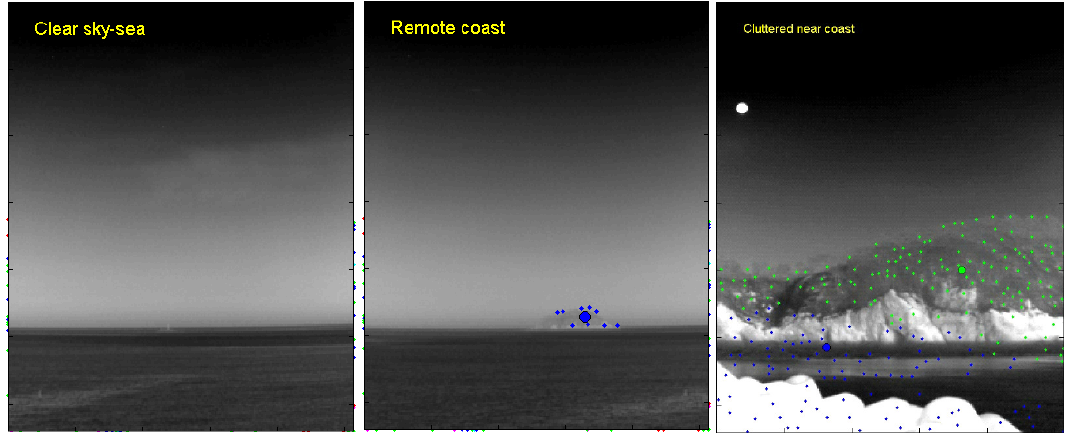
Figure 11. Examples of scene classification using the proposed background type